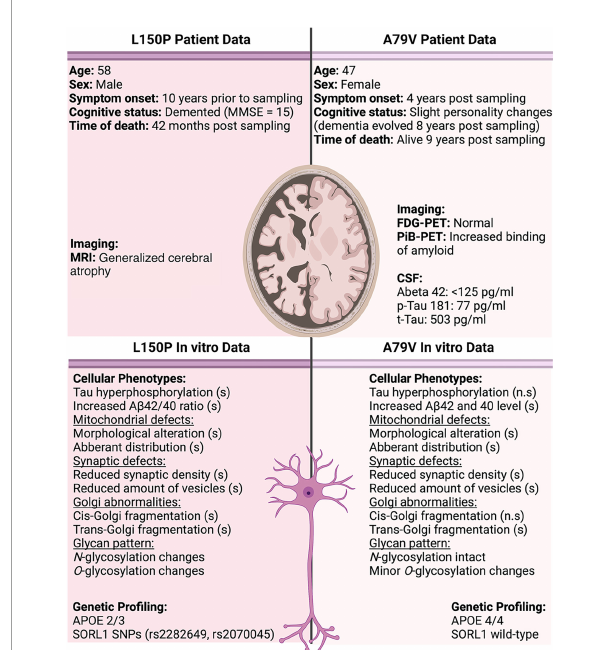
FIGURE6 Overview of patient data compared to observations in our in vitro cell models. Significant changes are indicated by (s), and non-significant by (n.s). CSF normal reference values; Abeta 42 > 400 pg/ml, p-Tau 181 < 80 pg/ml, and t -Tau < 300